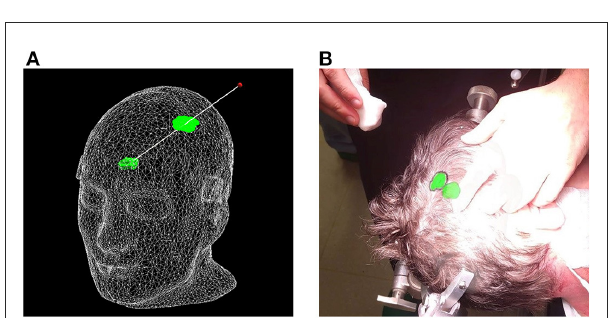
FIGURE7 Proposed surface-based tumor projection. (A) Wireframe model of the phantom with a deep-seeded tumor (green) projected upon the skin (green outline) nearest to the handheld stylus’ tip (red dot). The trajectory between the tumor and stylus is illustrated by the white line, and along with the wireframe skin, it is shown here purely for illustrative purposes and is not visible in the AR application. (B) Example of a clinical case, with the tumor displayed in its actual position as a 3D model inside the patient’s head, along with the orthographic projection on the patient’s skin, allowing the delineation of the tumor (black